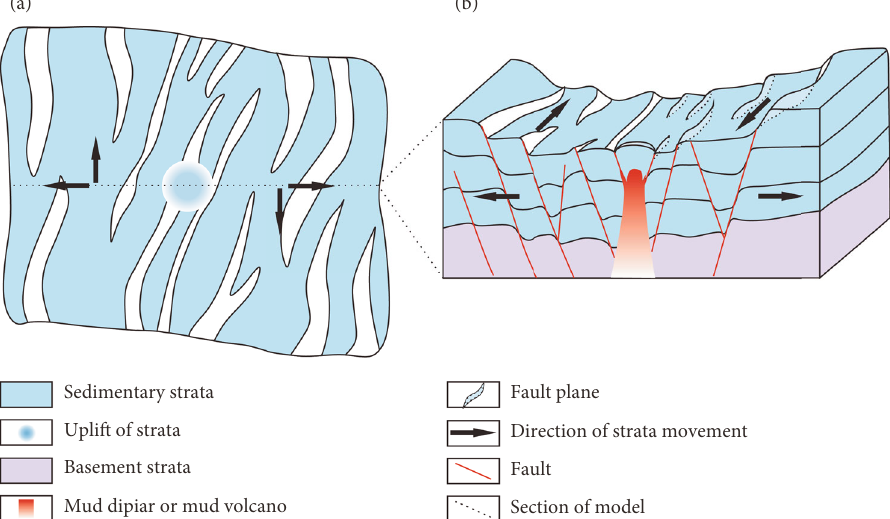
Figure 13: Development mechanism model of mud diapirs/mud volcanoes in the background of transtension. (a) The top view of the strata after the development of mud diapirs/mud volcanoes in the background of transtension. It can be observed that a stratigraphic uplift is on the position where mud diapir or mud volcano develops. There are nearly centrosymmetric fault zones in the strata on both sides. (b) Three- dimensional map of the development mechanism of mud diapirs/mud volcanoes under the background of transtension. The faults on both sides of mud diapir/mud volcano are well developed. Along the faults, muddy fl uid intrudes into the fault planes, and the top stratum is